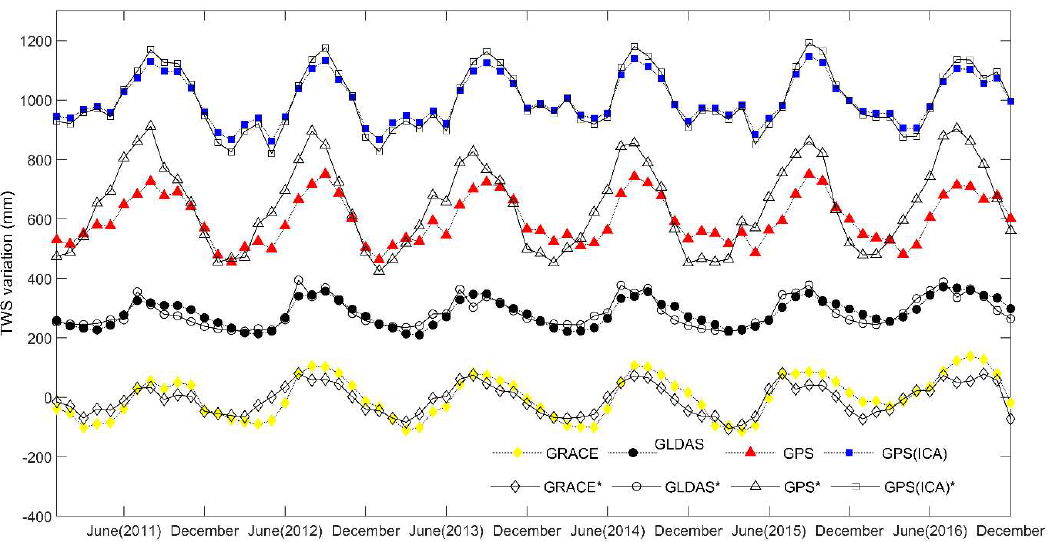
Figure 11. TWS variations in northwestern Sichuan-Yunnan and the entire region from 2011 to 2016. The averaged grid data of monthly TWS variations in northwestern Sichuan-Yunnan (* mark) and in the entire region.